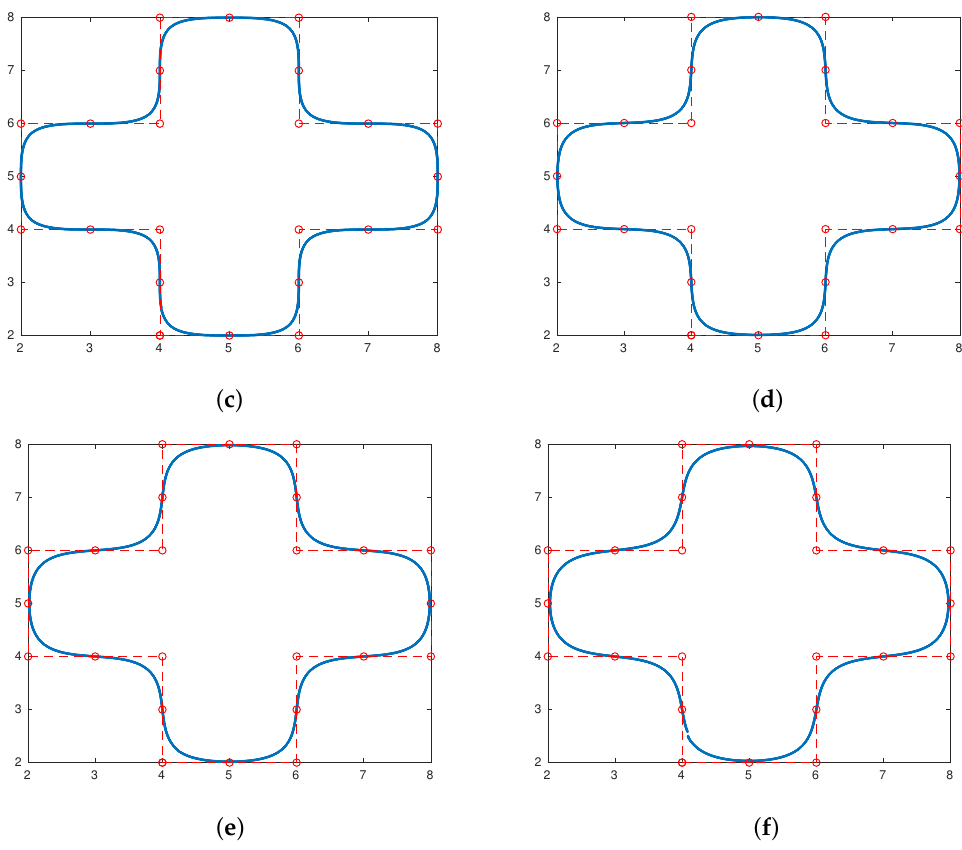
Figure 4. The limit functions in 2d using five subdivision scales; the results shown in ( a – f ) were obtained by S 0 (8), S 1 (10), S 2 (11), S 3 (13), S 4 (15) and S 5 (17), respectively, where w = 1 figure, the original sampling is represented in ◦ .